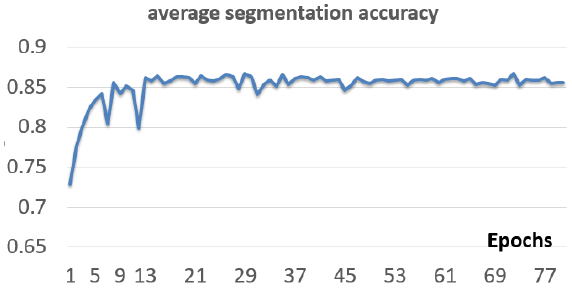
Figure 8. Progress of segmentation accuracy of BiseNet trained on